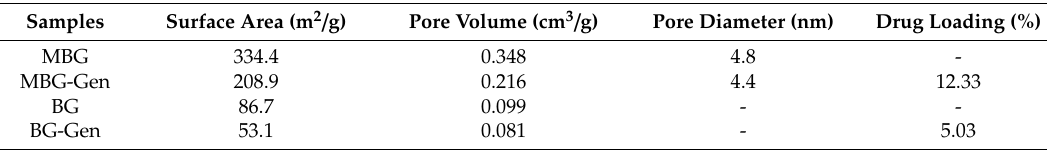
Table 3. Example of structural parameters of MBG and bioactive glass (BG) sca ff olds before and after